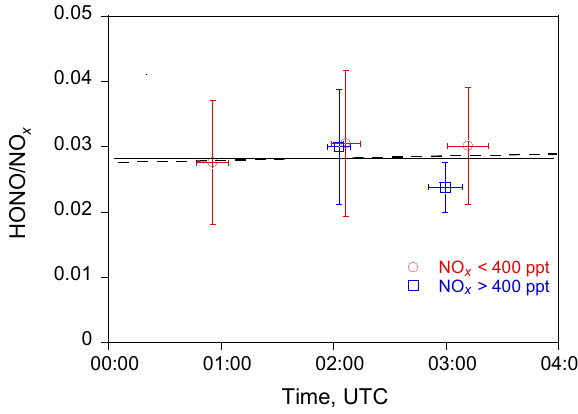
Figure 7. The evolution of the HONO / NO x ratio in the noc- turnal boundary layer during RF 18. The red circles and blue squares are the median HONO / NO x values under the conditions of NO x ≤ 400pptv and NO x > 400pptv, respectively. The horizon- tal bars indicate the averaging time periods and the vertical bars the 1 standard deviation of HONO / NO x ratios. The solid line is the least-squared fit to the data, and the dashed line indicates a slope of 3 × 10 − 4 h − 1 . The sunset time at the sampling location was